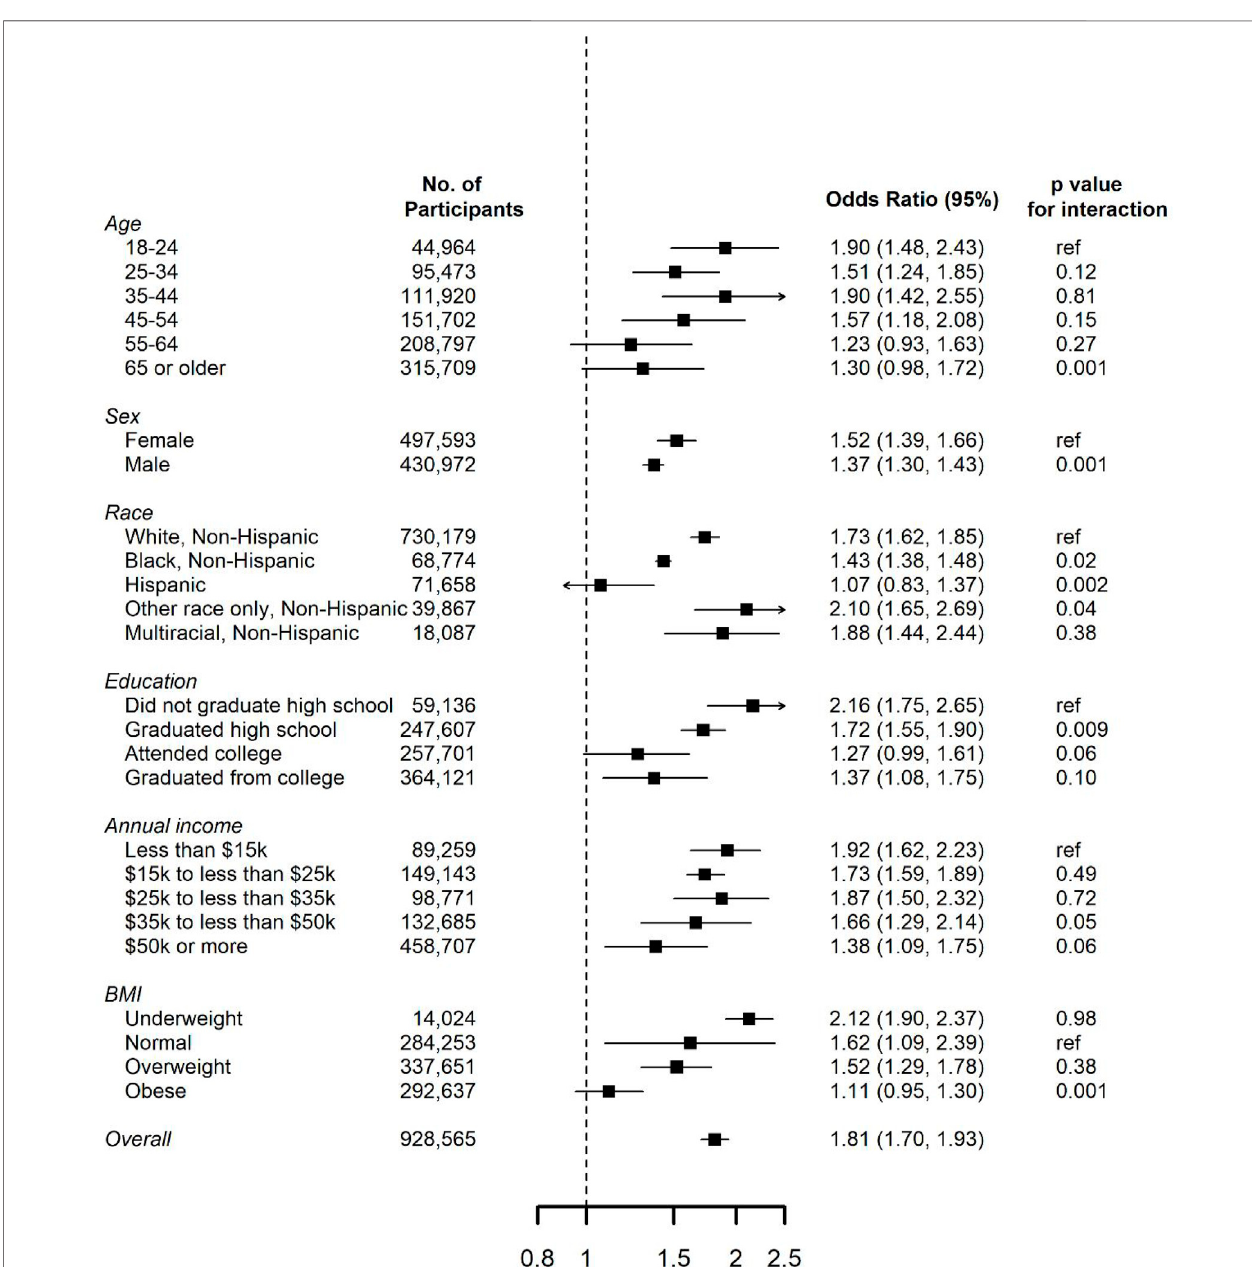
FIGURE2| Oddsratios(95%con fi denceinterval)forrisksofin fl ammatoryarthritisassociatedwithcurrente-cigaretteuseintheBehavioralRiskFactorSurveillance System (BRFSS) participants, by potential risk factors. ORs were adjusted for age group, sex, race, education levels, annual income, and BMI.